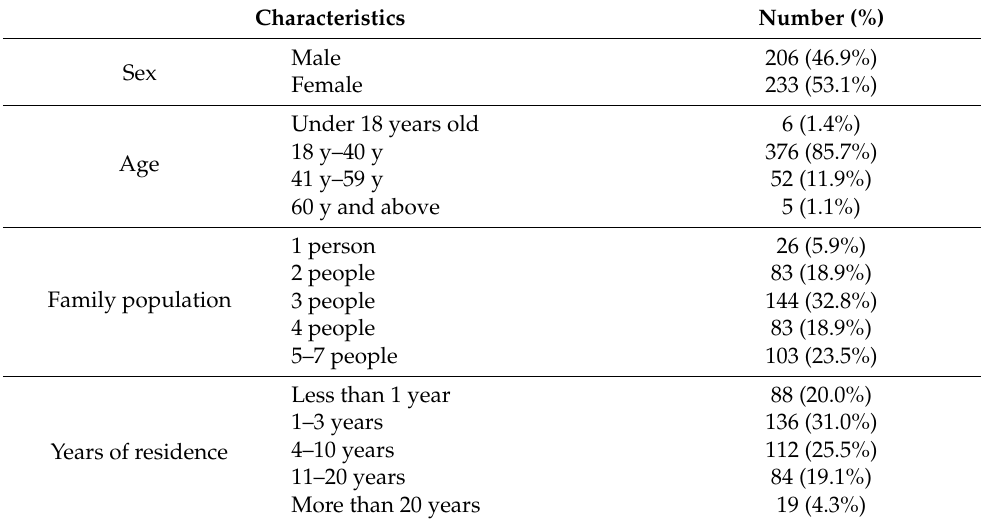
Table 2. Characteristics of the respondents.